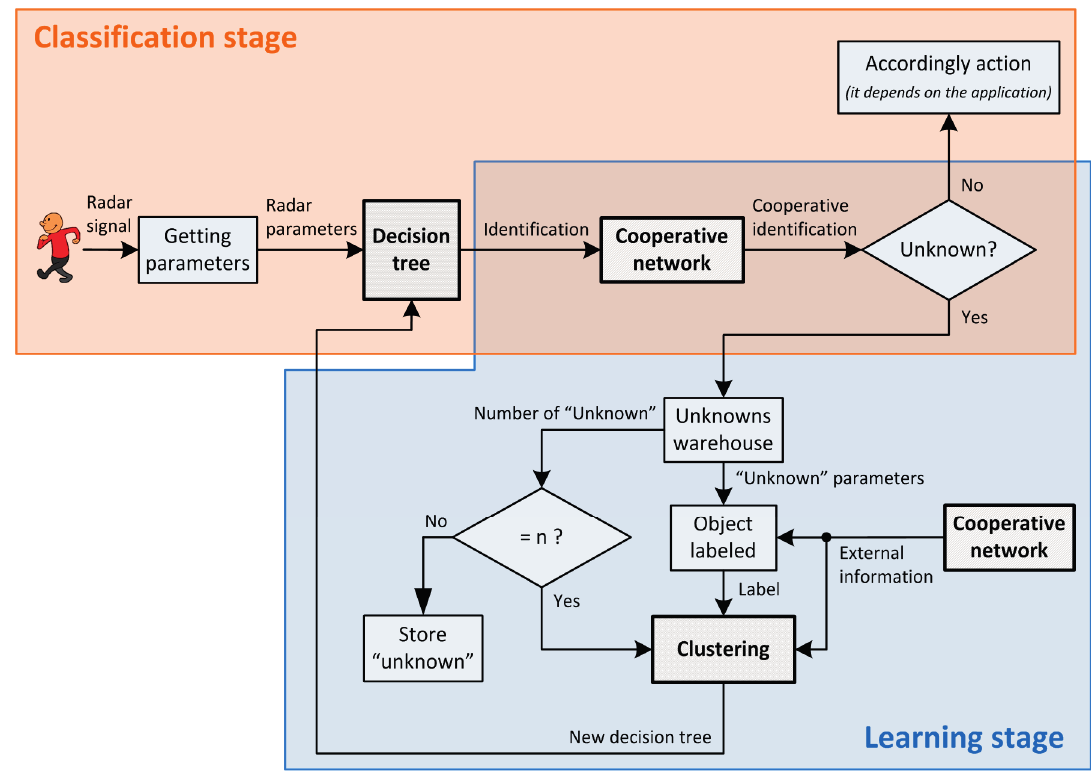
Figure 1. Whole scheme of the proposed system.